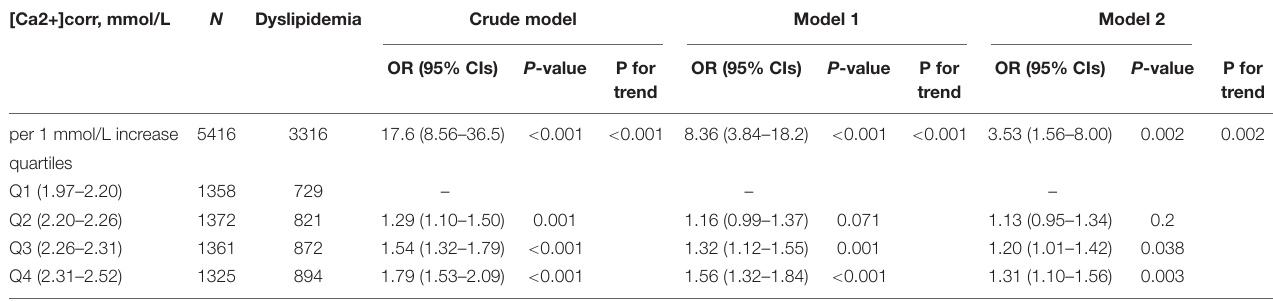
TABLE 2 | Associations between [Ca2+]corr and dyslipidemia odds in 5,416 adults assessed using logistic regression models. [Ca2+]corr, mmol/L N Dyslipidemia Crude model Model 1 Model 2